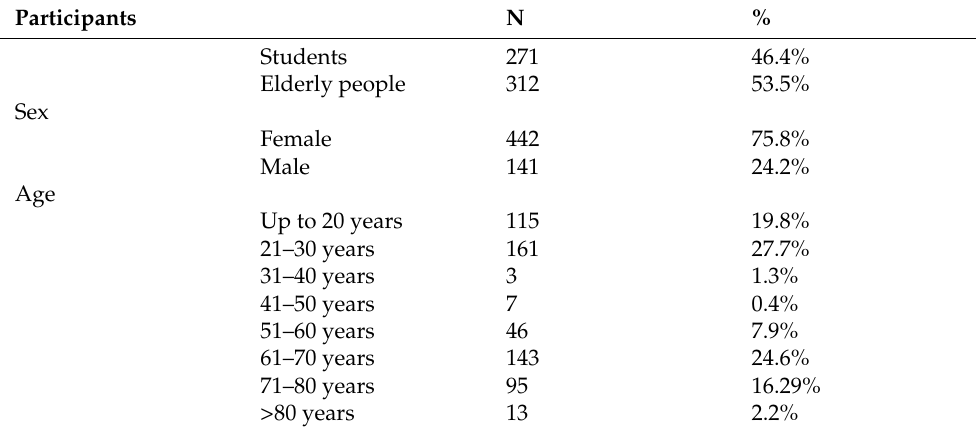
Table 1. Sample description (N = 583).